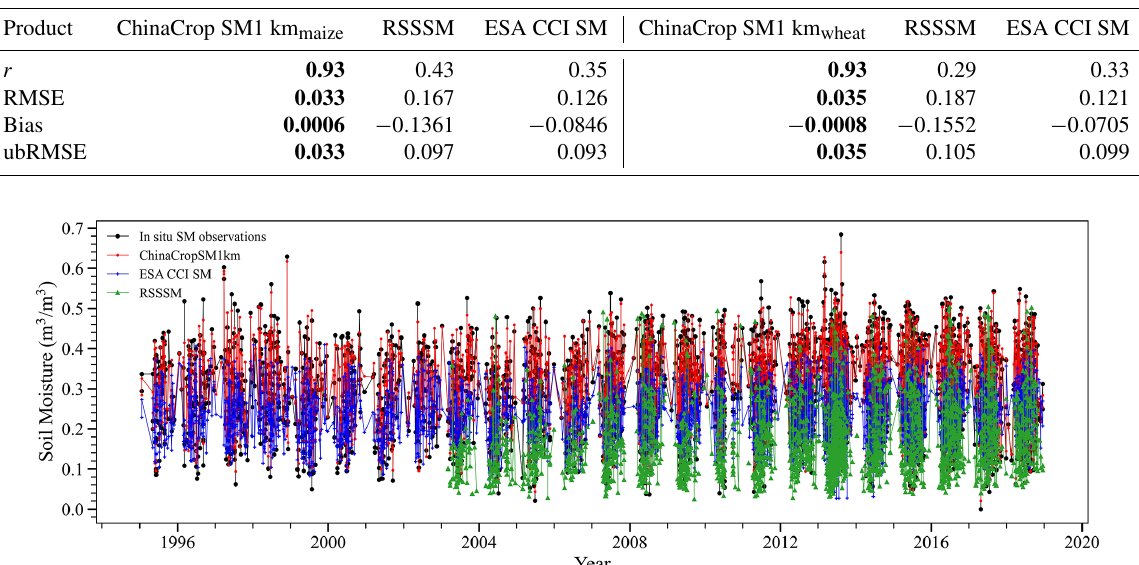
Table 3. Summary of means of evaluation indices ( r , bias, RMSE and ubRMSE) of three products (ChinaCropSM1 km, RSSSM and ESA CCI SM), with better performance highlighted in bold. All products were compared with in situ surface observations (0–10cm).